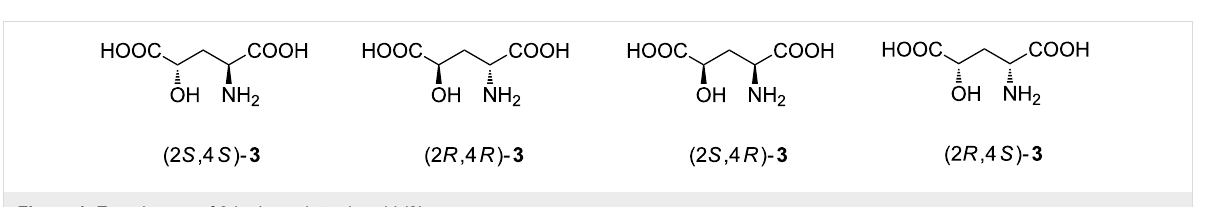
Figure 4: Enantiomers of 3-hydroxyglutamic acid ( 3 ).